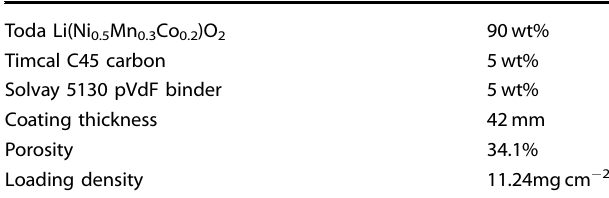
Table 4. Sample details on the composition of NMC532 used in this